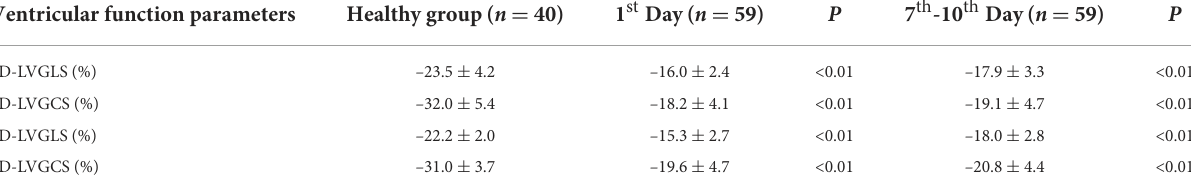
TABLE 4 2D- and 3D-STE strain in patients compared with healthy